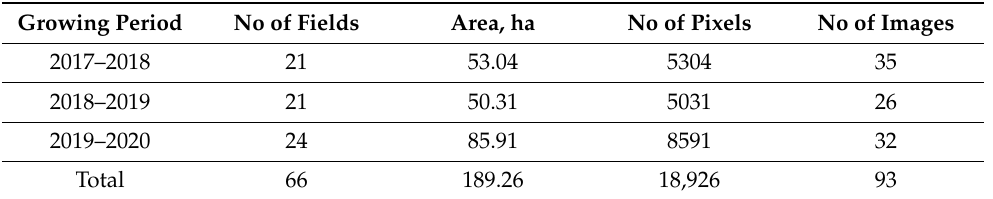
Table 1. Details of the studied fields. Growing Period No of